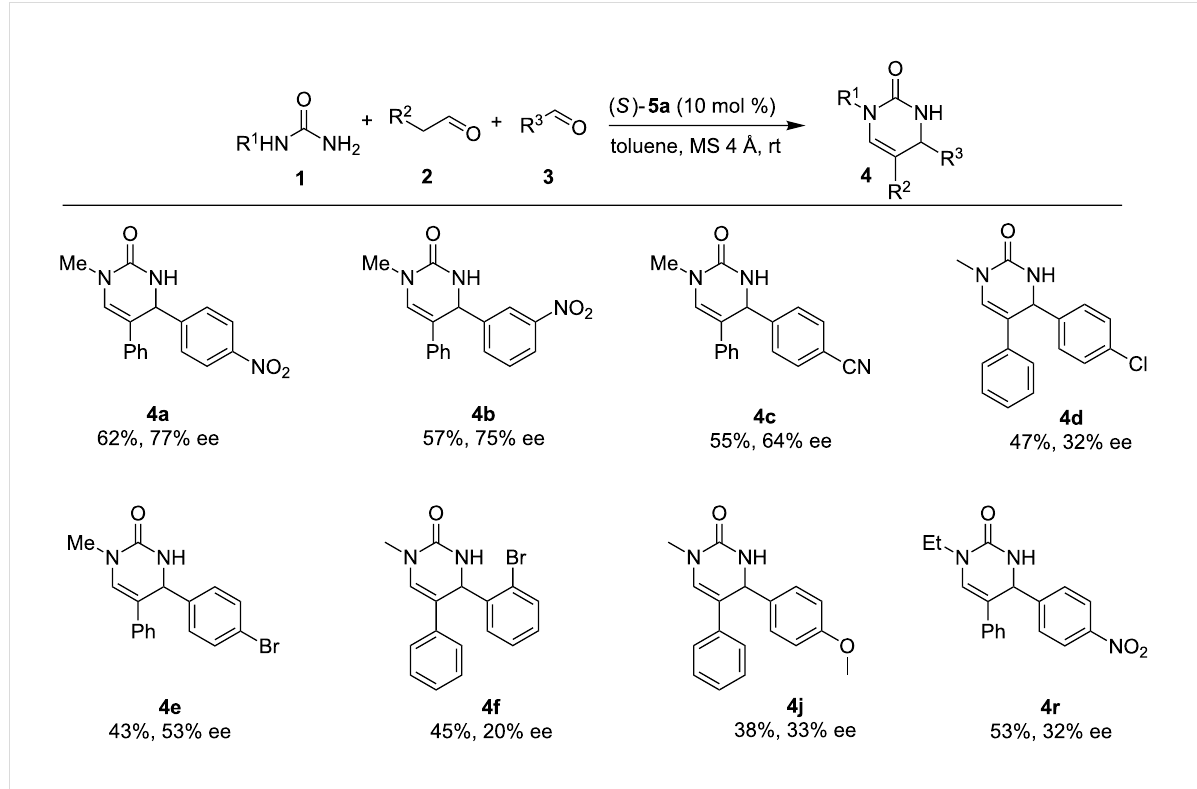
Figure 2: Scope of the enantioselective reaction. Reaction conditions: 5a (10 mol %, 0.02 mmol), 1 (0.2 mmol), 2 (0.2 mmol), 3 (0.3 mmol), MS 4 Å (0.1 g), toluene (1 mL), rt, 2 days. Isolated Yields were given. The ee’s were determined by chiral